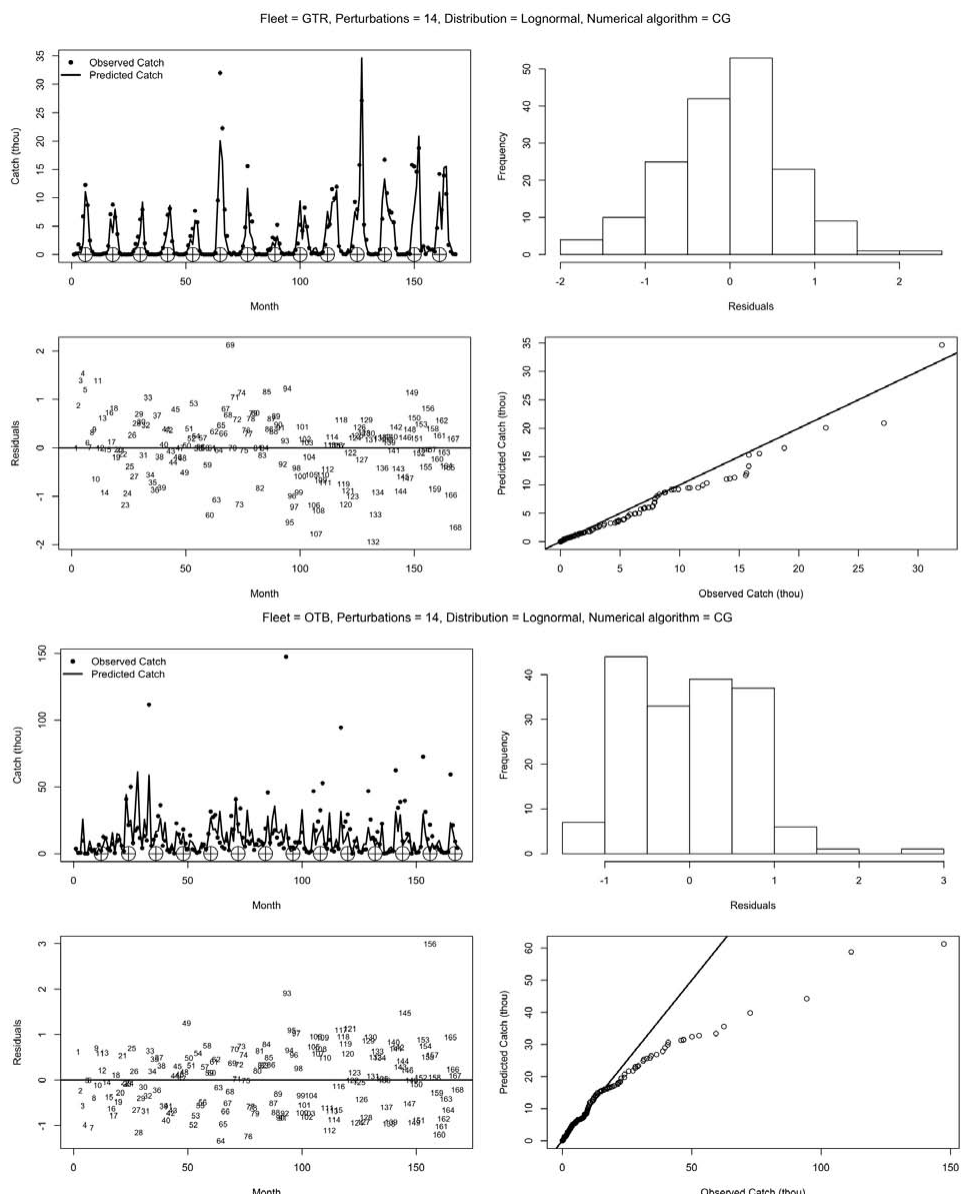
Fig. 6. – (Upper panel, trammel net (GTR); lower panel, bottom trawl (OTB)) Stock assessment prediction results for striped red mullet ( Mullus surmuletus ). Top left: predicted (continuous line) and observed catches in number. Target symbol shows the timing of the perturba- tions. Top right: empirical distribution of the residuals. Bottom left: scatter plot of the residuals. Bottom right: quantile-quantile plot of the generalized depletion